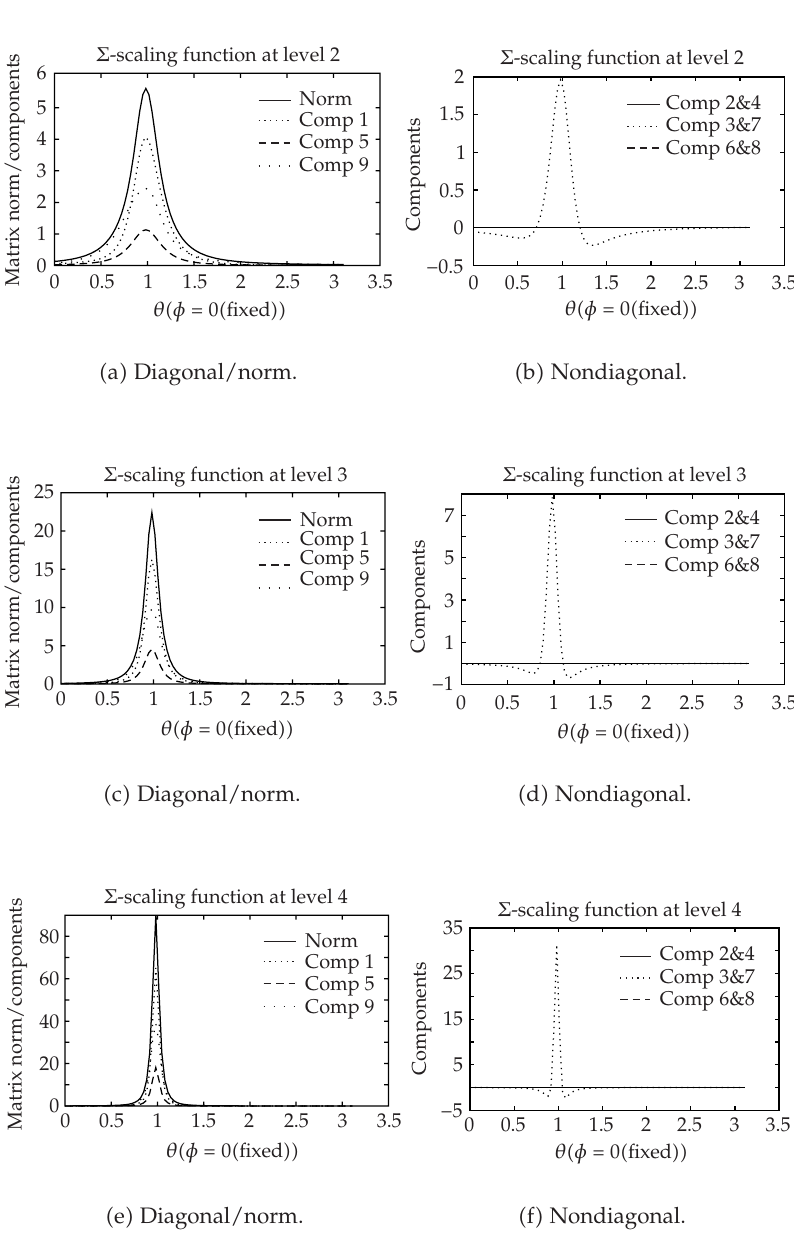
Figure 5.1 . Matrix norm ( Frobenius norm ) , diagonal, and non- diagonal components of the Σ -scaling function Φ j = 2 , 3 ,